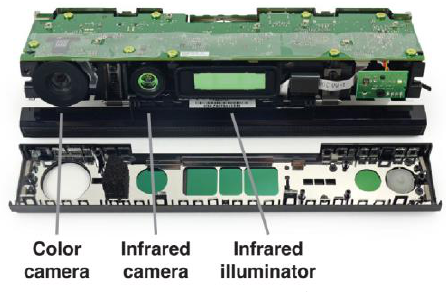
Figure 3. Sensor structure of Kinect